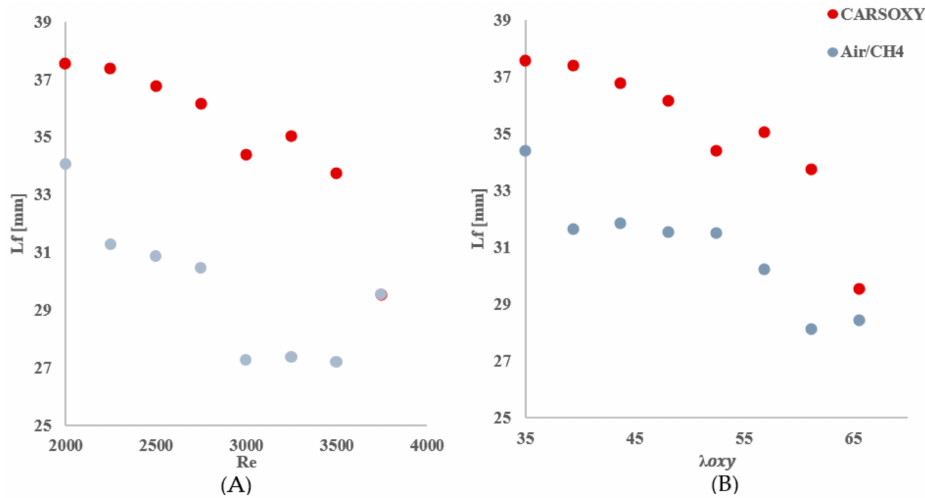
. V CH4 = 1 L/min and ( B ) λ oxy = [ 35 − 65.625 ]